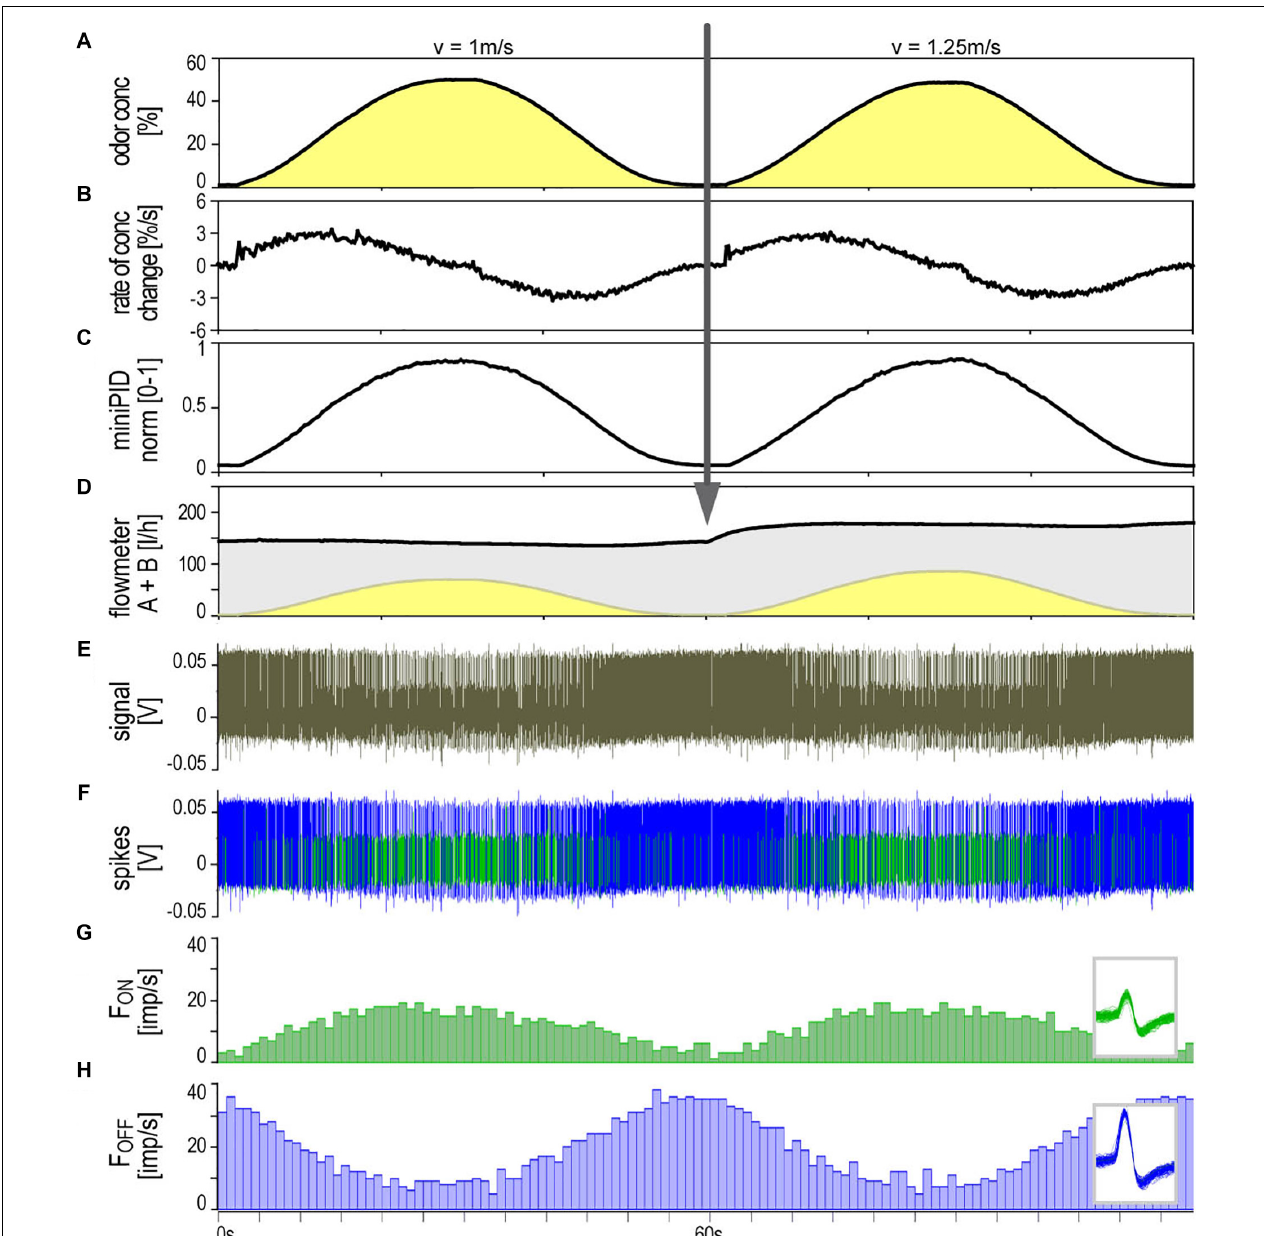
FIGURE 3 | Simultaneously recorded single sensillum responses of a pair of ON and OFF ORNs. Stimulation consisted of slow and continuous upward and downward changes of the concentration of lemon oil odorant delivered at two different air flow velocities. Arrow indicates change in air flow velocity from 1 to 1.25 m/s. (A) Time course of instantaneous odorant concentration. Duration of oscillation periods: 60 s. (B) Time course of the rate of concentration change. The maxima and minima of the oscillating rate of concentration change are in advance of the maxima and minima of the oscillating instantaneous odorant concentration (vertical dotted line). The noisy signal results from the slow rate of concentration change in a narrow range of ± 3.5%/s. (C) Time course of odorant concentration measured with a photoionization detector (miniPID). The signal values were normalized to the maximum value obtained in each experiment and set to 1. The concentration maxima and minima indicated by the oscillating flowmeter A signal (A) correspond with the concentration maxima and minima of the PID signal. (D) Time course of the summed flow rates of the odor-saturated air stream measured with flowmeter A (yellow oscillations) and the clean air stream measured with flowmeter B (gray oscillations, inverse to yellow oscillations); the summed flow rates of both air streams were used to calculate the air flow velocity of the olfactory stimulus. (E) Extracellularly recorded activity of the ORNs. Both types discharge continuously during the concentration cycles. The OFF ORN typically generates greater impulse amplitudes than the ON ORN. (F) Off-line sorted action potentials of the ORNs obtained by spike detecting and template matching techniques using Spike2 software (Cambridge Electronic Design, United Kingdom). Green impulses originate from the ON ORN, blue impulses from the OFF ORN. (G,H) Instantaneous impulse frequency of the ON and OFF ORNs, respectively; bin width, 0.2 s. Insets action potentials classified by matching the shape of each action potential against shape templates. Template windows show template boundaries of spike waveforms from the two ORNs. F impulse frequency, v velocity.